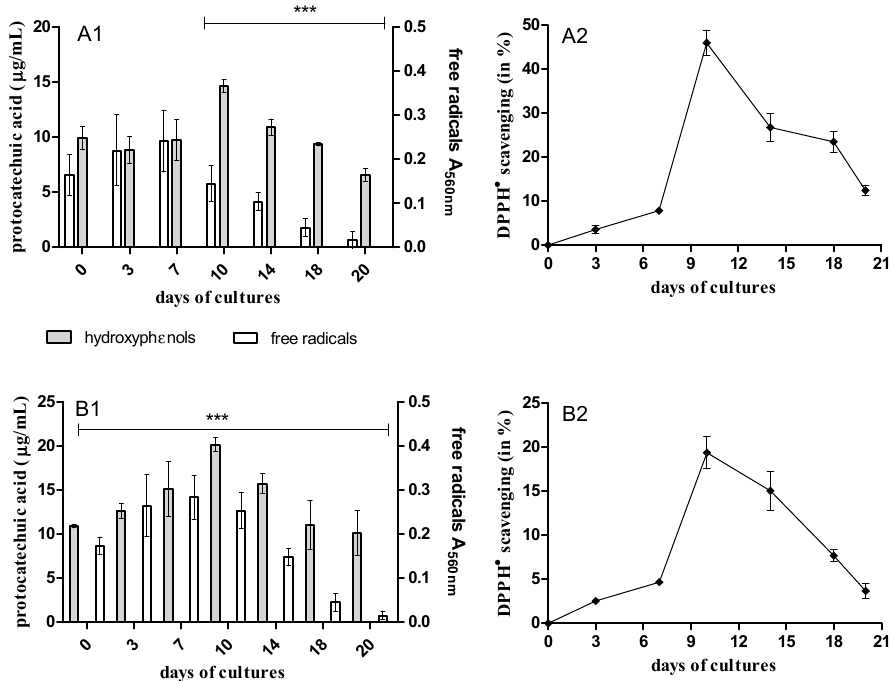
Figure 2. The content of phenols (µg/mL of protocatechuic acid), level of free radicals (A 560nm ) (1) and antioxidants properties (2) during treatment of DNR ( A ) or DOX ( B ) by B. adusta CCBAS 930 *** p < 0.001.